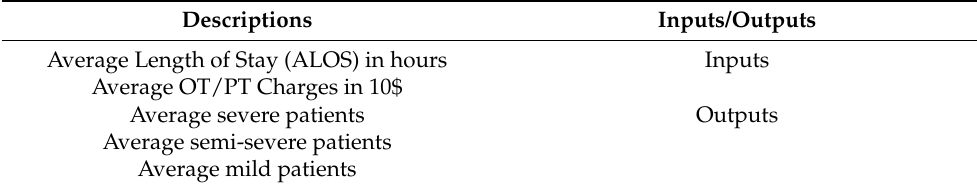
Table 1. The description of inputs and outputs in hospitals.